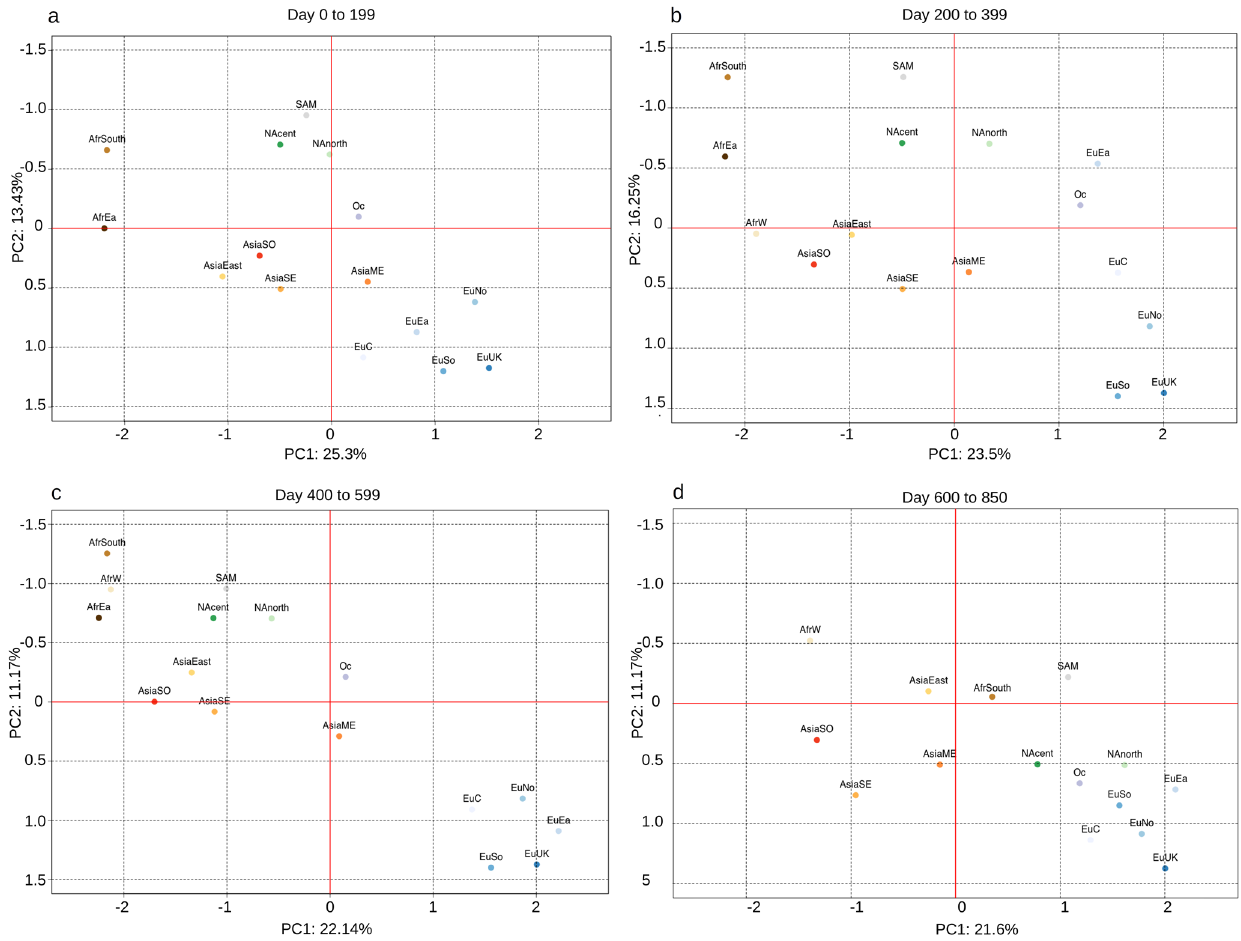
Fig. 1 Principal component analysis of genomic variants frequencies in different geographic macro-areas. Four distinct time intervals are considered, with time T0 set at Time 0 = December 26th 2019: the day of reported isolation of the fi rst SARS-CoV-2 genomic sequence. a from day 0 to 199. b from day 200 to 399. c from day 400 to 599, d from day 600 to 850. The following acronym are used for different geographic areas AfrCent Central Africa, AfrEast Eastern Africa, AfrN Northern Africa, AfrSouth Southern Africa, AfrW Western Africa, AsiaCent Central Asia, AsiaEast Eastern Asia,